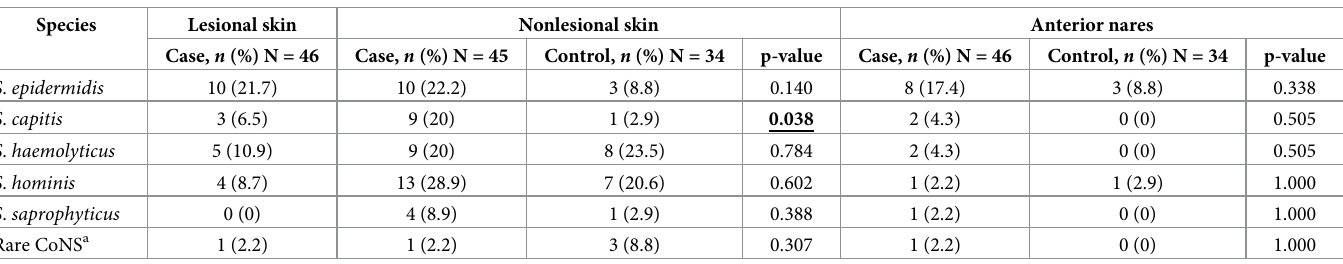
Table 3. CoNS species identified on the skin and anterior nares of Cape Town (urban) cases and controls.